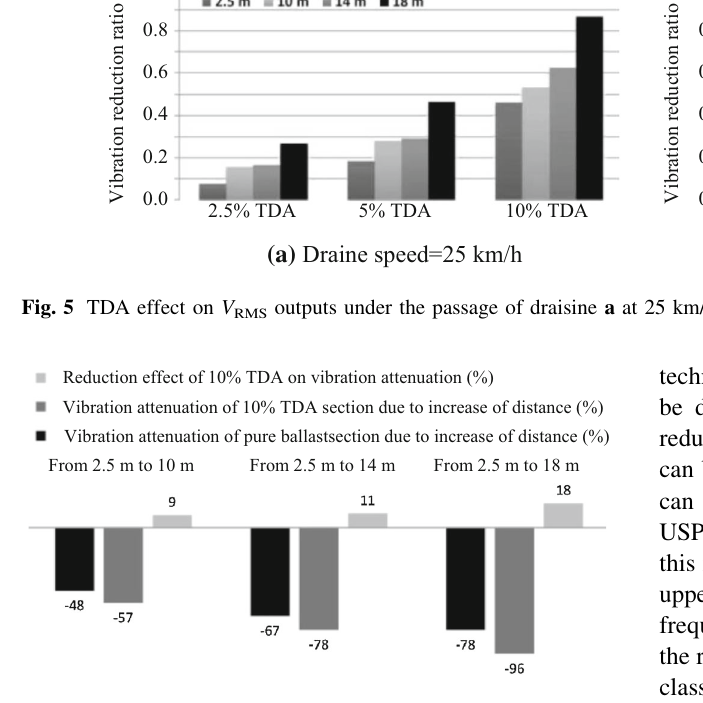
Fig. 6 Vibration attenuation of pure ballast and 10% TDA section (in dB)